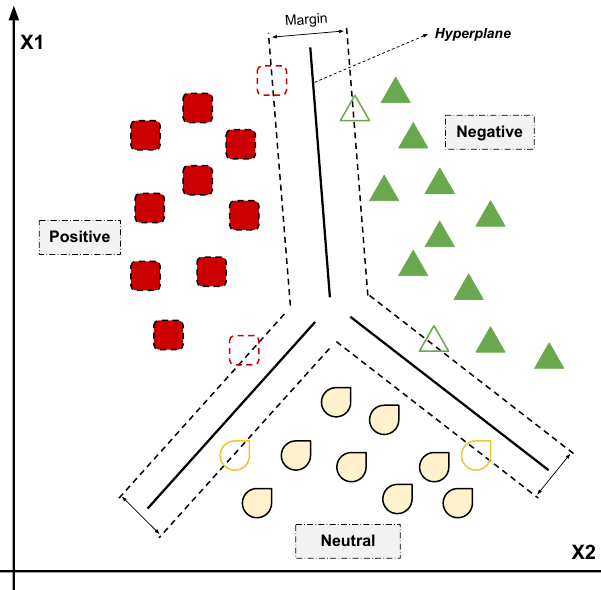
Figure 1. Three-class classification by